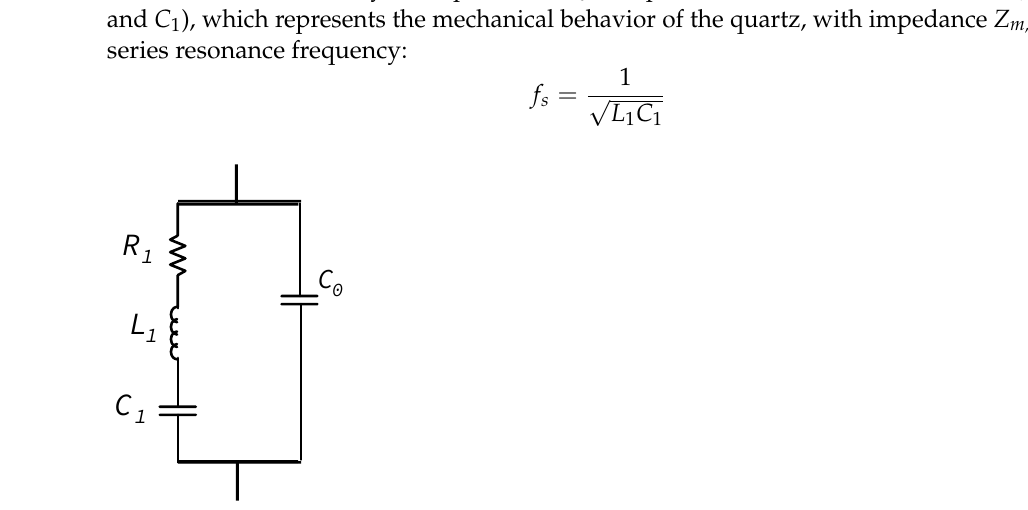
Figure 2. Butterworth van Dyke (BVD) model of the quartz resonator.